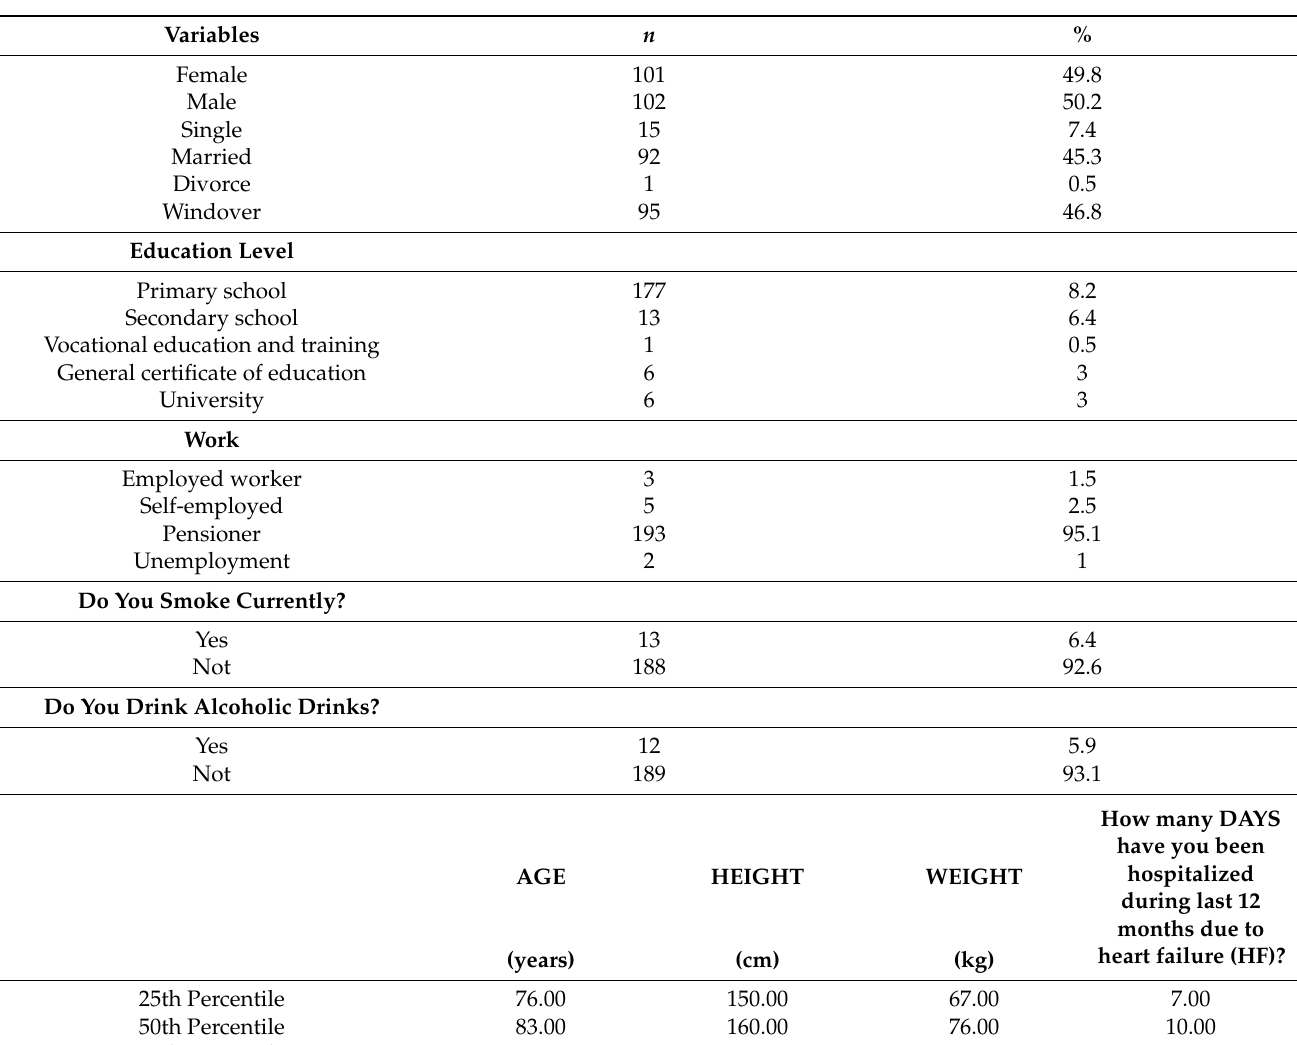
Table 1. Main sociodemographic characteristics of the sample ( n =